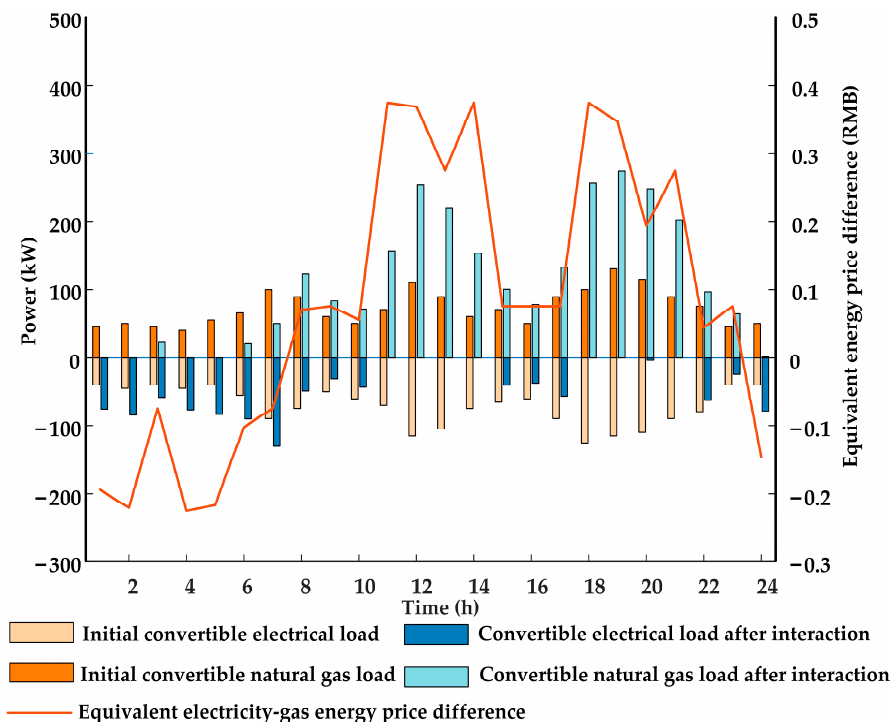
Figure 7. The relation between the convertible load and the equivalent energy price difference.